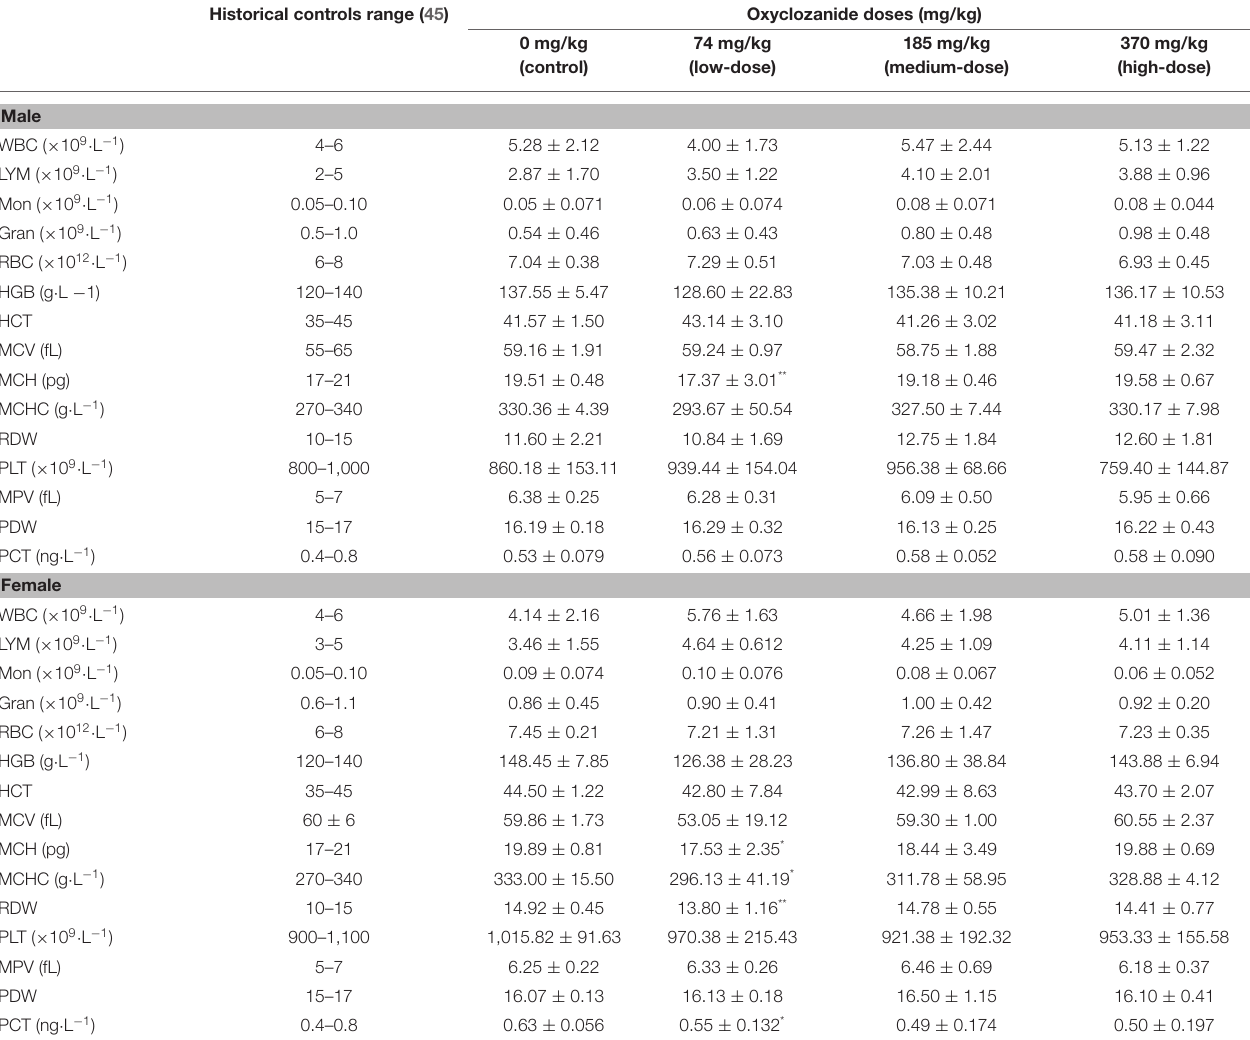
TABLE 2 | Haematological values of rats in oxyclozanide-treated group and control group. Historical controls range